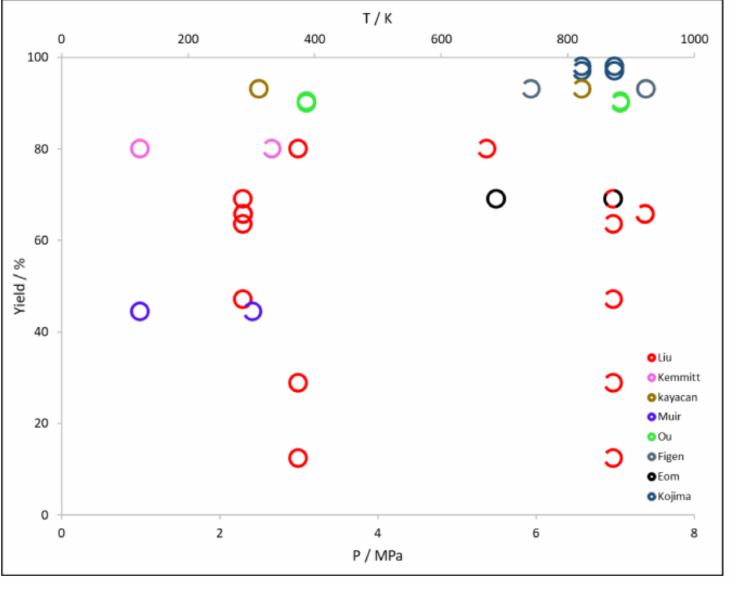
Figure 4. Reported yields for NaBH 4 regeneration through thermochemical